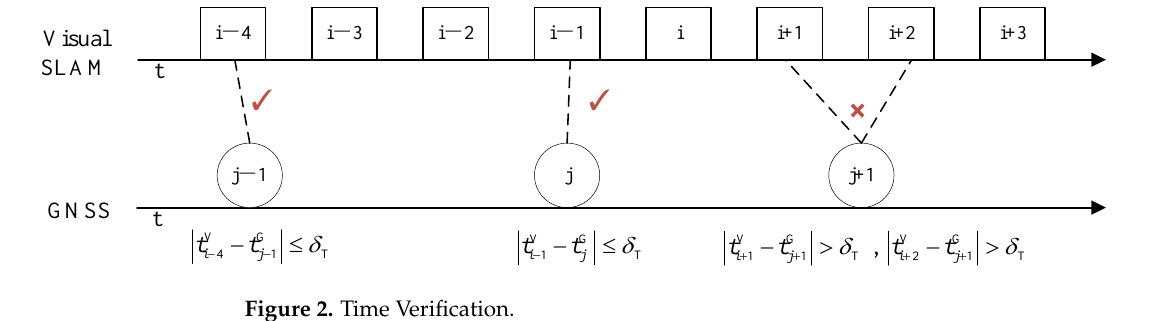
Figure 2. Time Verification .